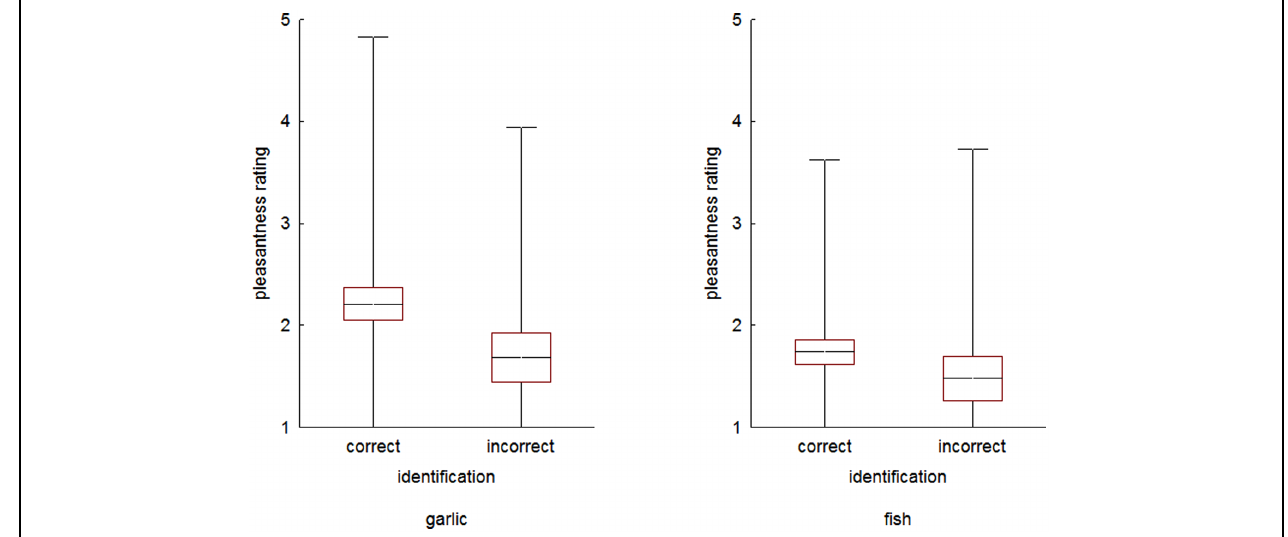
FIGURE 2 | Ratings of pleasantness in children who correctly identified and those who did not for the odors of garlic and fish. Middle line denotes mean, boxes ± SEM and error bars ± 2SD. The differences are significant at p > 0.05.